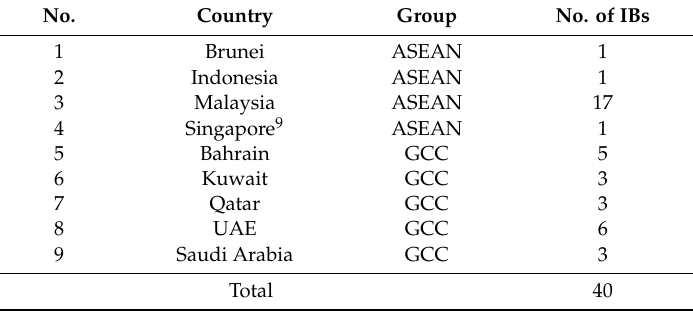
Table 1. Number of Sampled Islamic Banks (IBs) in Association of South East Asian Nations (ASEAN) and Gulf Cooperation Council (GCC). No. Country Group No. of IBs 1 Brunei ASEAN 1 2 Indonesia ASEAN 1 3 Malaysia ASEAN 17 4 Singapore 9 ASEAN 1 5 Bahrain GCC 5 6 Kuwait GCC 3 7 Qatar GCC 3 8 UAE GCC 6 9 Saudi Arabia GCC 3 Total